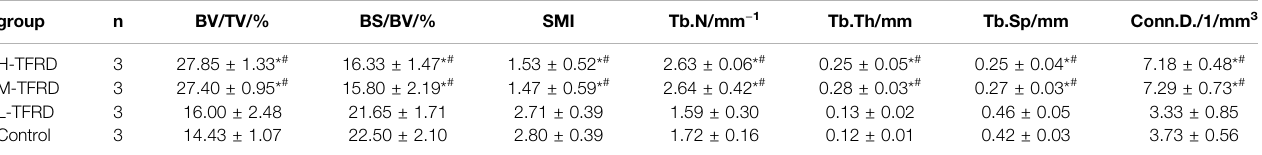
TABLE 2 | Comparison of the parameters of bone structure in the area of bone graft in each group. Each value was presented as the mean ± SD. * p < 0.05 Vs. the control group; # p < 0.05 Vs. the L-TFRD. group